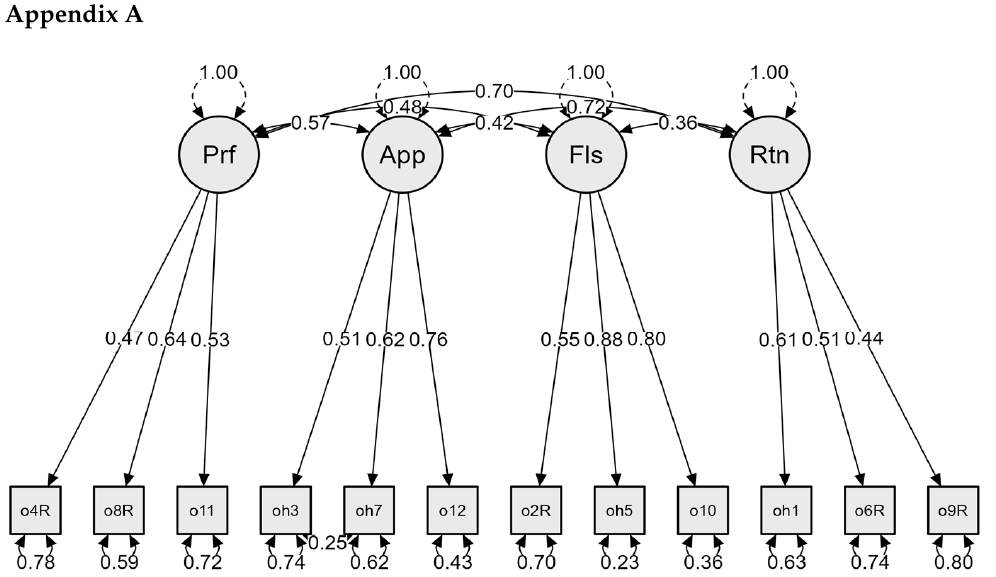
Figure A1. Confirmatory factor analysis of the OHVS with the standardized factor loading. Reversed items are denoted by R. Prf: professional, App: appearance, Fls: flossing, RTN: retaining